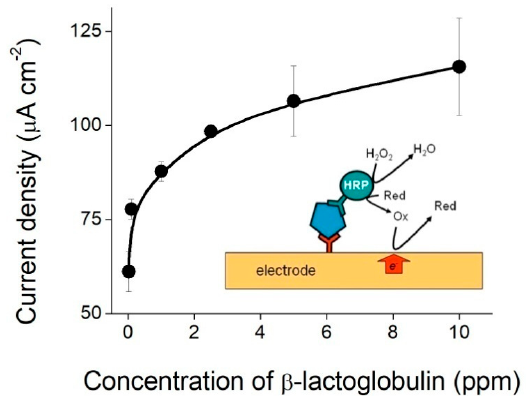
Figure 5. Electrochemical determination of β -lactoglobulin. Dependence of the current measured at 60 s on the β -lactoglobulin concentration at an applied potential of − 0.280 V. Error bars were calculated from the standard deviation of three independent experiments. The experimental points were fitted to a power law: y = 91.2 x 0.095 , where y corresponds to the current density expressed in μ A cm − 2 and x to the concentration of β -lactoglobulin expressed in ppm ( R 2 = 0.977). Inset: Schematic representation of the capture immunoassay for the electrochemical determination of β -lactoglobulin (blue pentagon); Red and Ox stand for hydroquinone and 1,4 benzoquinone, respectively.